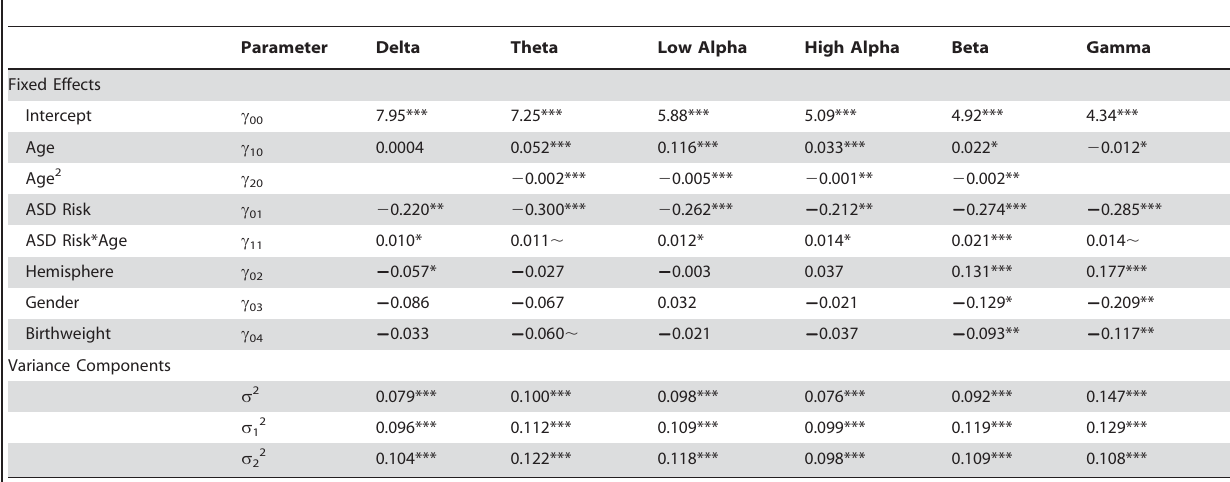
Table 5. Estimates of fixed and random effects from individual growth models in which ASD risk predicts initial status and the rate of change in spectral power in infants between 6 and 24